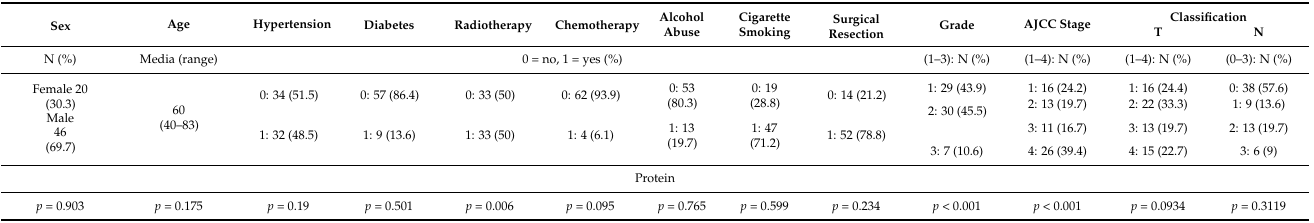
For the group of 82 patients (66 with OSCC + 16 controls, H-score), the p -value was estimated to find any significant difference in ZNF-281 level according to Grade, AJCC Stage and T and N classifications with the Kruskal–Wallis one-way ANOVA test, whereas that according to other parameters was estimated with the Mann–Whitney U test. Table 2. The impact of different factors on ZNF-281 mRNA levels. Clinical characteristics of 48 patients with mRNA levels.